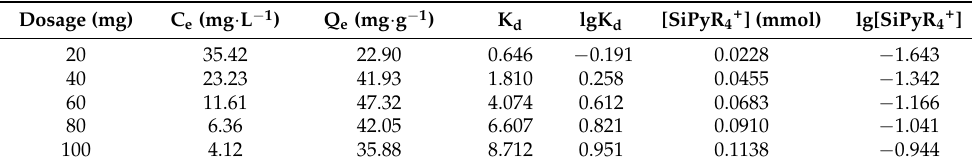
Table 7. Adsorption mechanism experiment